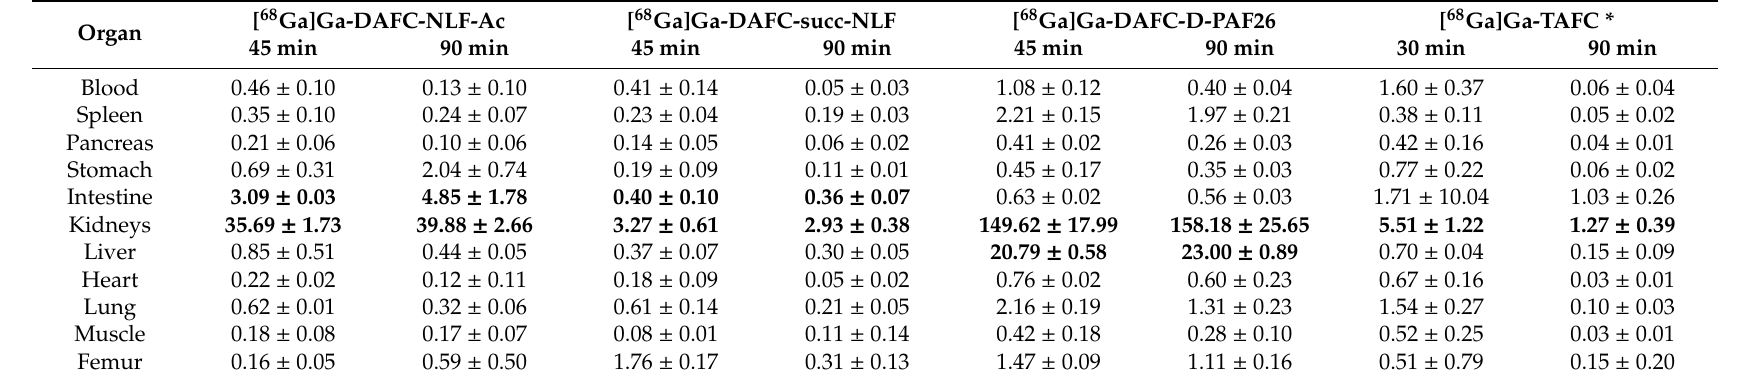
Table 5. Biodistribution of gallium-68 labelled compounds in standard BALB / c mice after 45 and 90 min shown as injected dose per gram tissue (%ID / g). Each value represents three biological replicates, crucial numbers are highlighted in bold. * Data of [ 68 Ga]Ga-TAFC are adapted from reference [31].